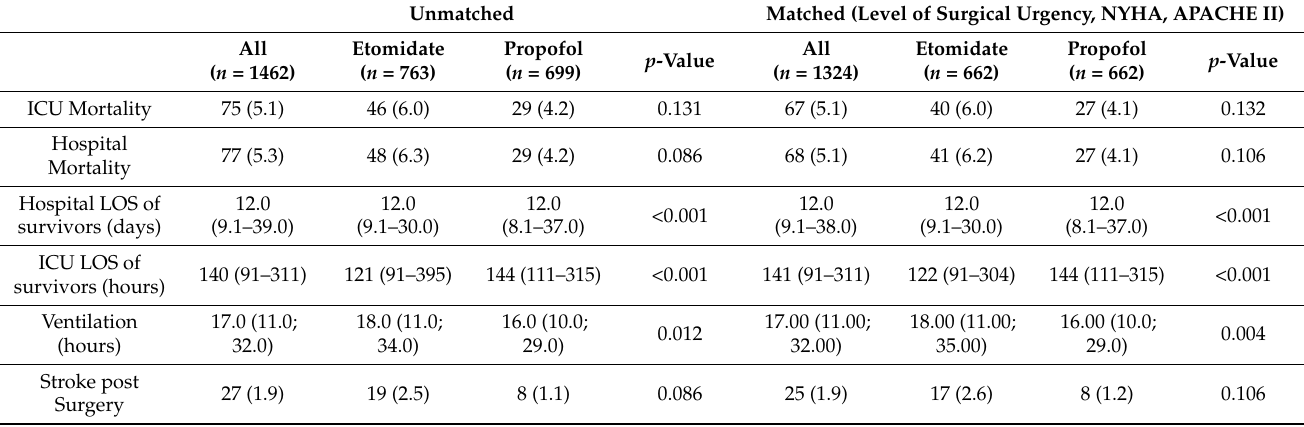
Table 3. General outcome